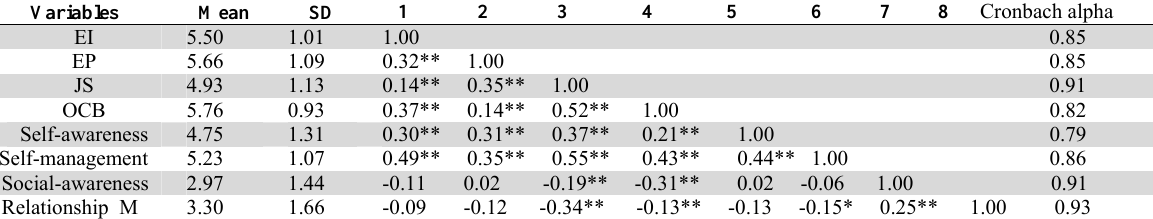
Mean, Standard deviations, Correlations among Constructs & Cronbach alpha Variables